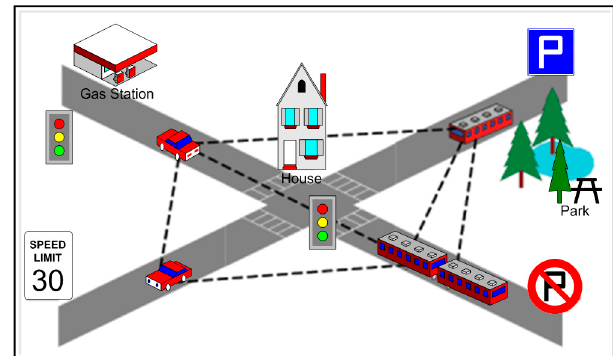
Figure 2. Pure ad-hoc networks.